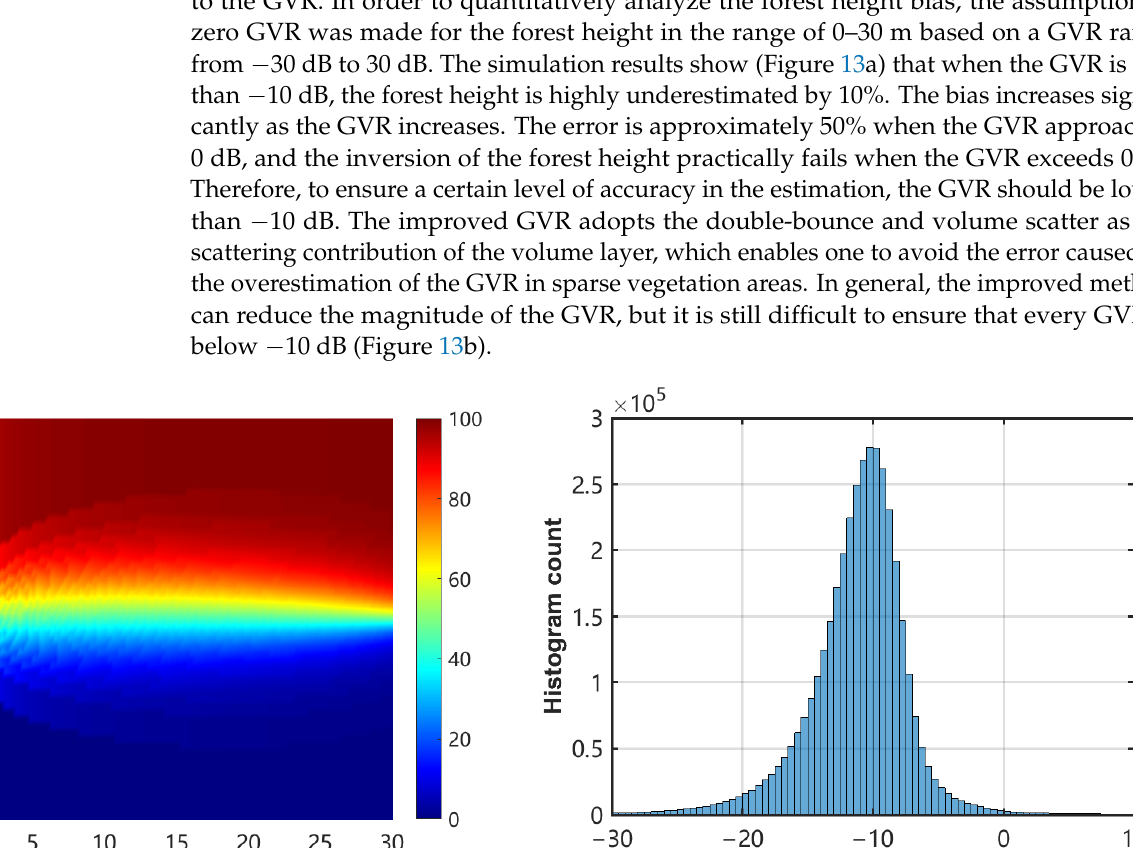
Figure 14. Fifteen common complex coherences (HH, HV, VV, HHVV, HH+VV, HH − VV, HV+VH, LL, LR, RR, Opt1, Opt2, Opt3, PD High, PD Low) and the complex coherences ( 𝛾 𝐺 , 𝛾 𝑉 ) obtained in this study were used for the comparison of GVR at low and high forest stand densities. Left: low density; right: high density. Because the L-band has penetrating properties, the volume and double-bounce scat- tering increase significantly with the increasing forest stand density and the growth of trees, and the GVR decreases, which is conducive to height inversion. For dense canopies, only the upper canopy returns to backscatter, which greatly increases scattering on the canopy surface, rather than volume scattering. Compared to dense forests, in sparse for- ests, electromagnetic wave attenuation decreases when propagating to the forest layer,